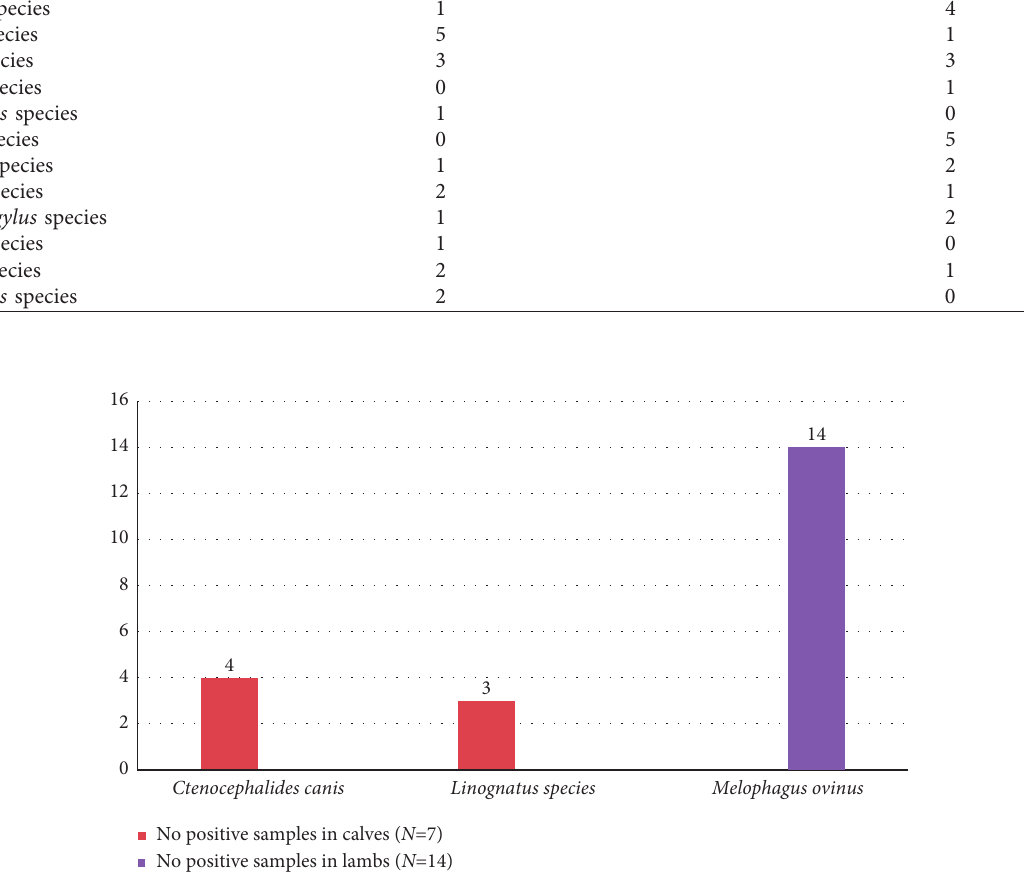
Figure 3: Frequency of ectoparasite species identified during the skin scrapping.